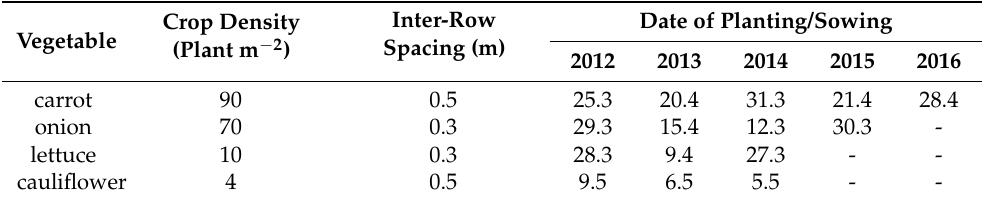
Table 1. Crop and plot arrangements.